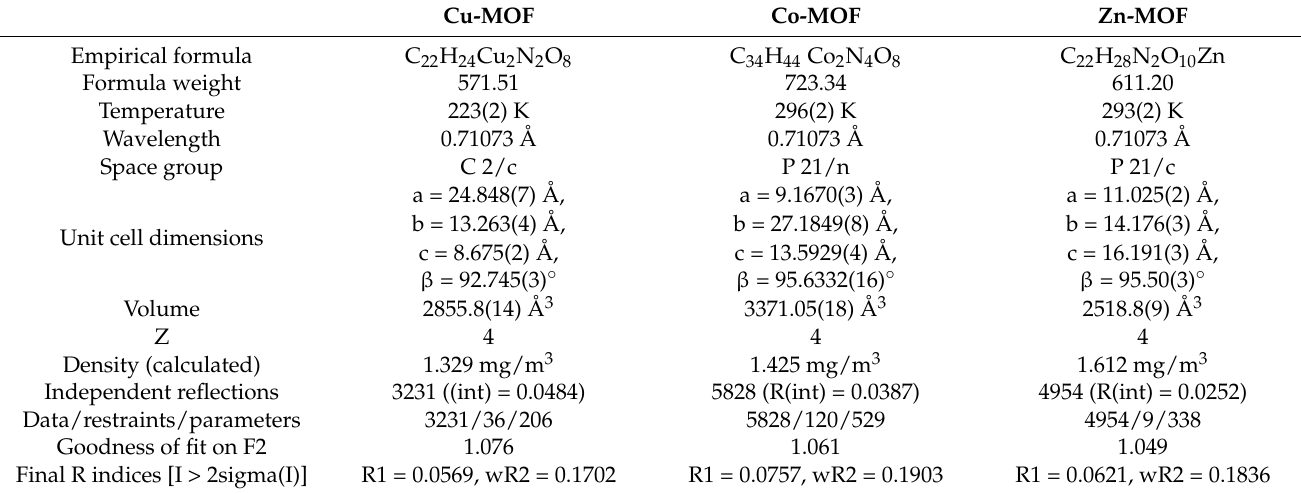
Table 1. Crystal data and structure refinement for the Cu-MOF, Co-MOF, and Zn-MOF. Cu-MOF Co-MOF Zn-MOF Empirical